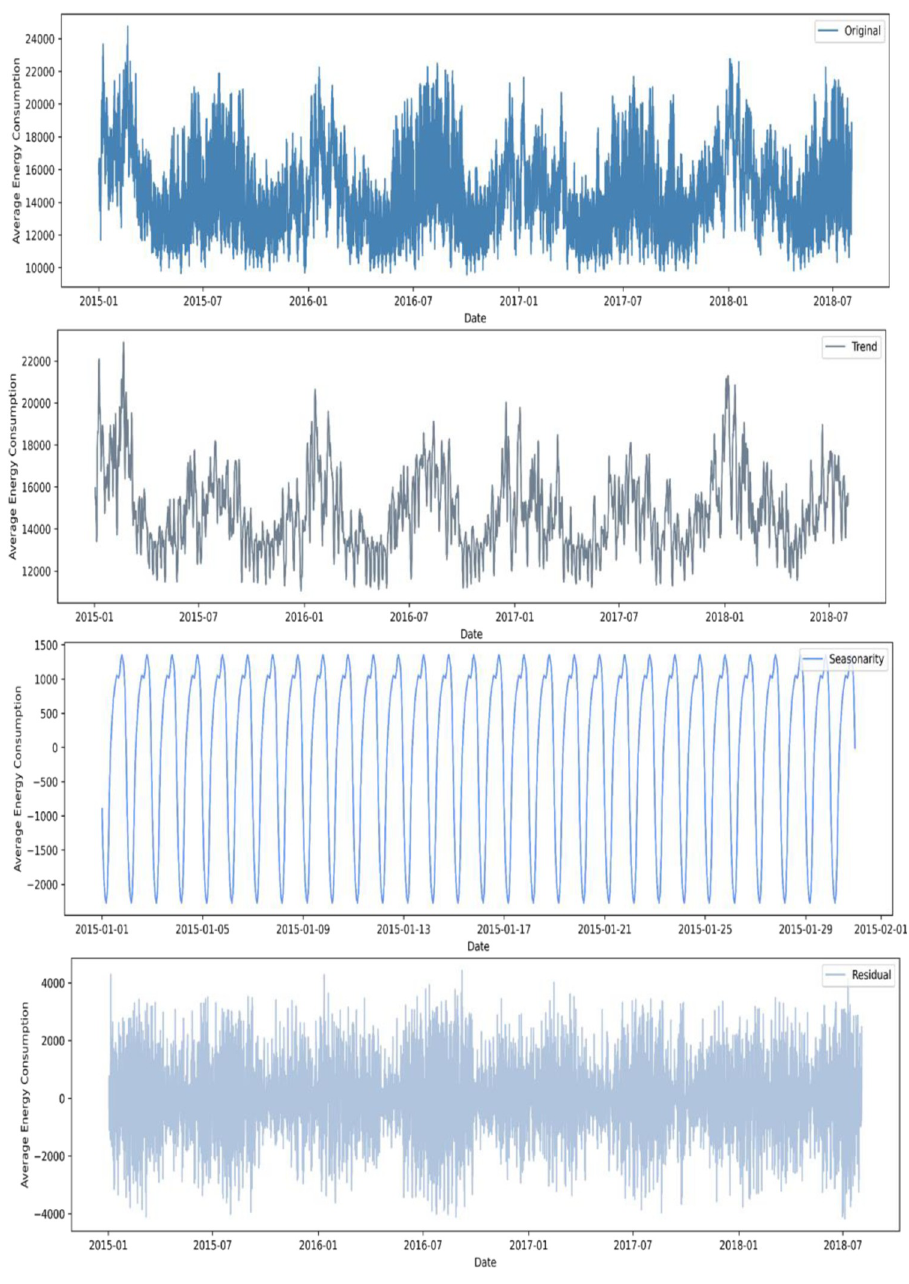
Fig 6. Each feature after Prophet